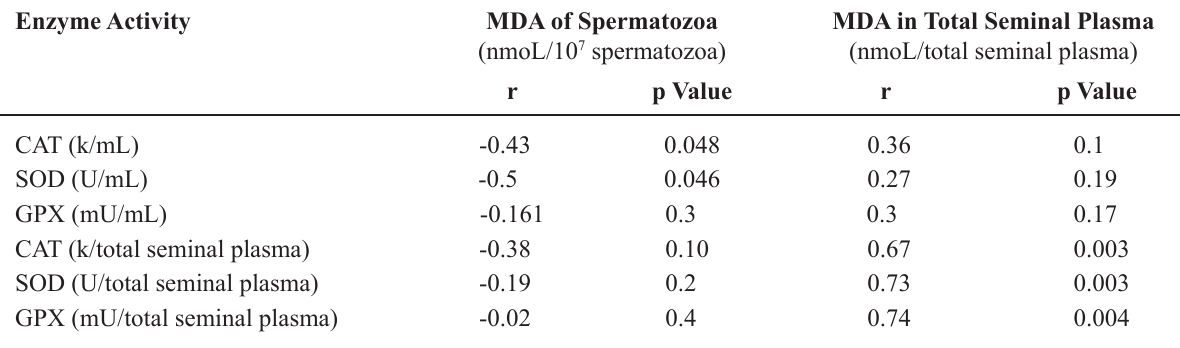
Table 3 – Correlations between catalase (CAT), superoxide dismutase (SOD) and glutathione peroxidase (GPX) activities with malondialdehyde (MDA) content of spermatozoa and seminal plasma from normozoospermic (n = 15) samples.